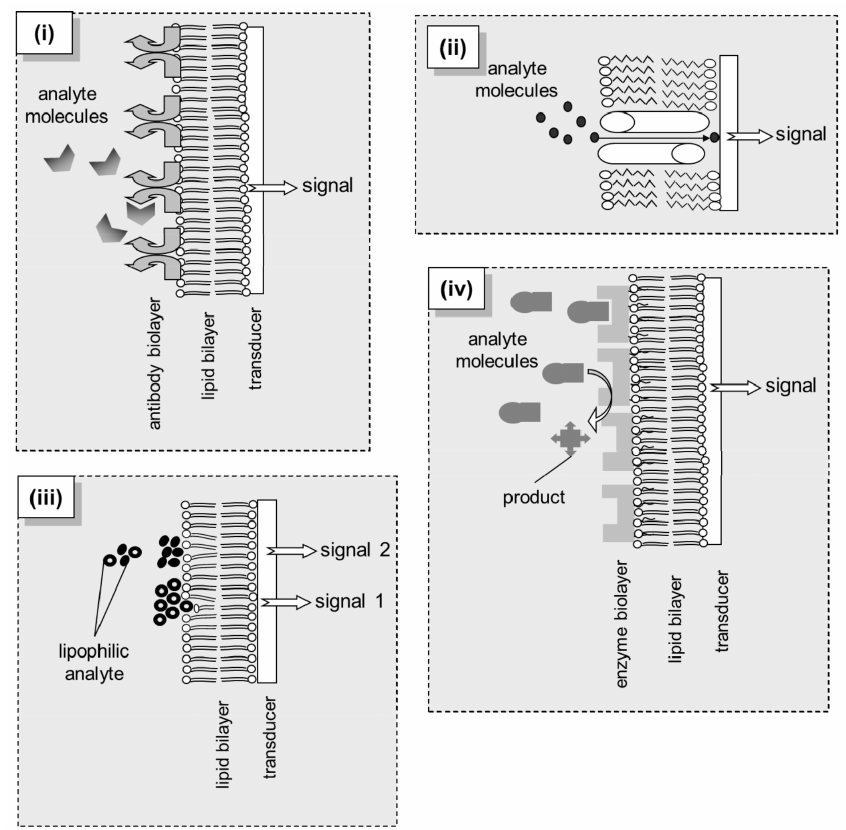
Figure 1. Different principles of biosensing via structured lipid bilayer interfaces: ( i ) Immunosensing: the antigen is recognized by the antibody attached to the lipid film; complementation induces structural changes to the immobilized unit that trigger transient modifications to the packing of lipids, expressed as a transient modification of the transmembrane current. ( ii ) Channel-based sensing: transport or channel proteins are incorporated into the lipid bilayer; these moieties transfer the analyte through the membrane, thereby permanently increasing the transmembrane current. ( iii ) Lipid adsorption-based sensing: mixtures of similar lipophilic compounds are adsorbed onto the bilayer surface inducing lipid packing modifications that result in transmembrane current alterations; using a slight difference at the partition coefficients of the mixture components, a series of discrete signals can be produced, each one indicating, with adequate resolution, each analyte species in the mixture. ( iv ) Enzyme-based sensing: the analyte is converted by the membrane-immobilized enzymes; the reaction induces electrochemical changes to the bilayer-solution interface (Debye length) resulting in modifications of surface charge or dipolar potential of the membrane, expressed as a transient modification of the transmembrane